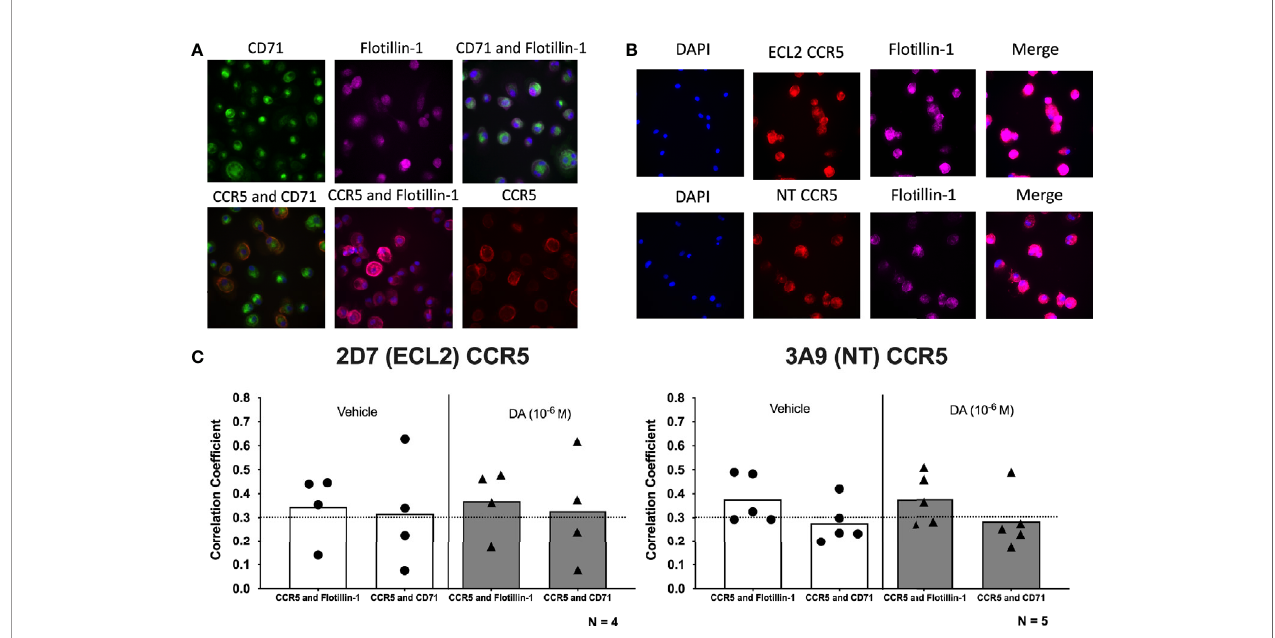
FIGURE 5 | Dopamine does not alter the localization of speci fi c CCR5 conformations within the plasma membrane. (A) Representative images of immunocytochemical staining of hMDM with CCR5 (red), the non-lipid raft marker CD71 (green), and the lipid raft marker fl otillin-1 (purple), as well as overlay images of CCR5 and CD71 (orange), CCR5 and fl otillin-1 (pink), and CD71 and fl otillin-1 (blue). Images were acquired on the Cell Insight CX7 automated 7-channel confocal microscope, imaging 100 fi elds per well using a 40x objective in a 96-well plate. (B) Representative images of immunocytochemical staining of hMDM with DAPI (blue), 2D7 or 3A9 CCR5 (red), fl otillin-1 (purple), and merged. (C) Quantitative analysis using Pearson ’ s correlation coef fi cient shows a positive correlation for 2D7 CCR5 and fl otillin-1 as well as 2D7 CCR5 and CD71 in both vehicle-treated and dopamine-treated cultures ECL2 CCR5: Flotillin-1, vehicle PCC = 0.345, dopamine PCC = 0.369; ECL2 CCR5:CD71, vehicle PCC = 0.317, dopamine PCC = 0.328. In contrast, colocalization of NT CCR5 was only shown between NT CCR5 and Flotillin-1, with NT CCR5 showing no colocalization with CD71 (NT CCR5: Flotillin-1, vehicle PCC = 0.377, dopamine PCC = 0.376; NT CCR5:CD71, vehicle PCC = 0.277, dopamine PCC = ECL2 CCR5/Flotillin-1 colocalization in either condition ( Figure 5C ). In contrast, PCC did not show colocalization between NT CCR5 and CD71, although this was shown for ECL2 CCR5.